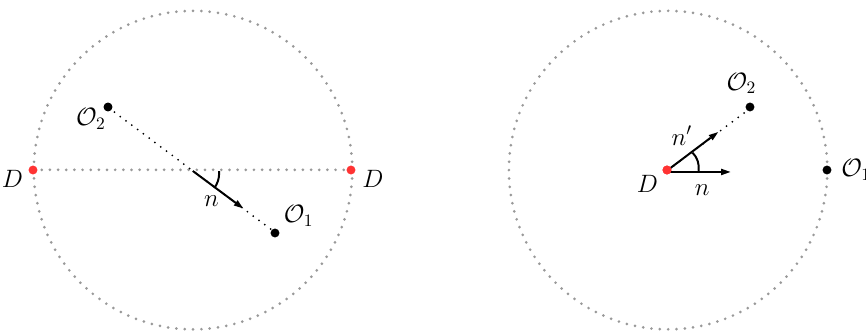
Figure 1 . The bulk and defect radial frames, corresponding to equations (3.33) and (3.36). Bulk radial frame (left): the defect is spherical and orthogonal to the plane drawn in the (cid:12)gure, and crosses it at the position marked by the red dots. The operators r . Defect radial frame (right): the defect is (cid:13)at and orthogonal to the plane drawn in the (cid:12)gure, and crosses it at the position marked by the red dot. The operator lies at radius ^ r